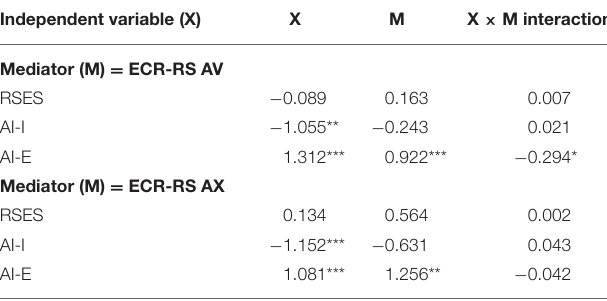
TABLE 4 | Mediation effects of attachment avoidance and attachment anxiety on the self-esteem/motivation to effect of the acceptance of sugar relationships in older participants ( n = 429); unstandardized